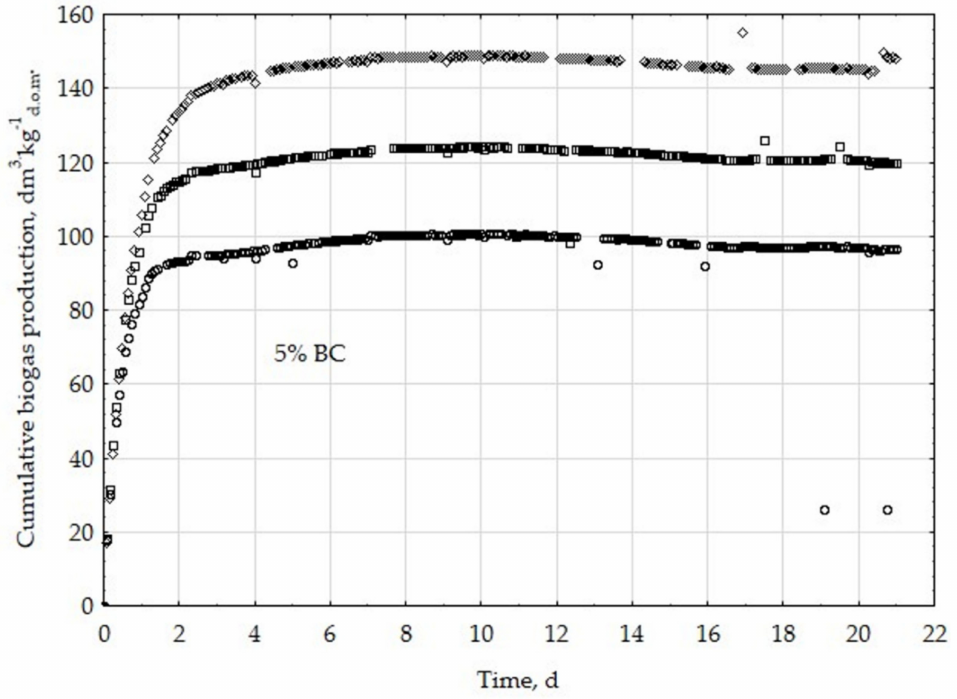
Figure A4. Biogas production from BSG: cumulative curves in variant with biochar addition at the level of 5%. The number of repetitions was